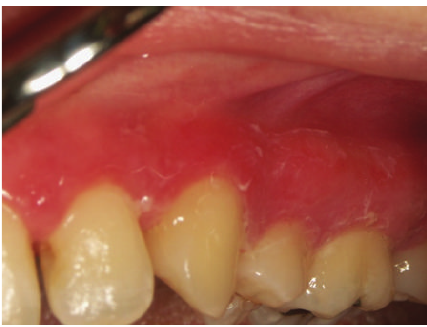
Figure 4: Sloughing of the upper gingiva due to the 0.2% chlorhex- idine digluconate.